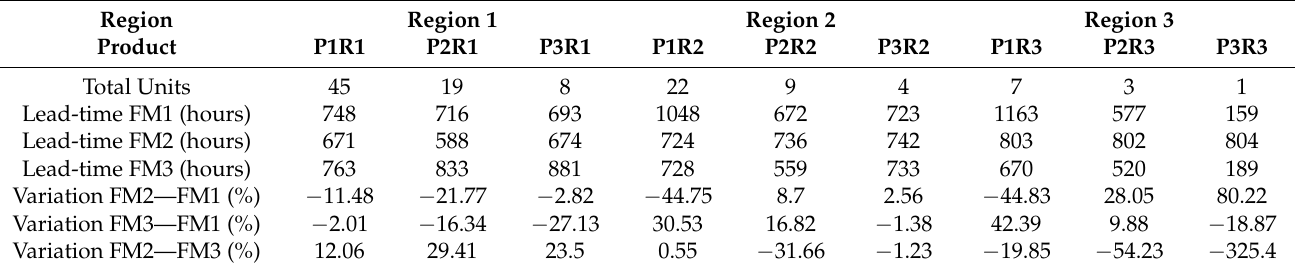
Table 12. Lead time and scenario